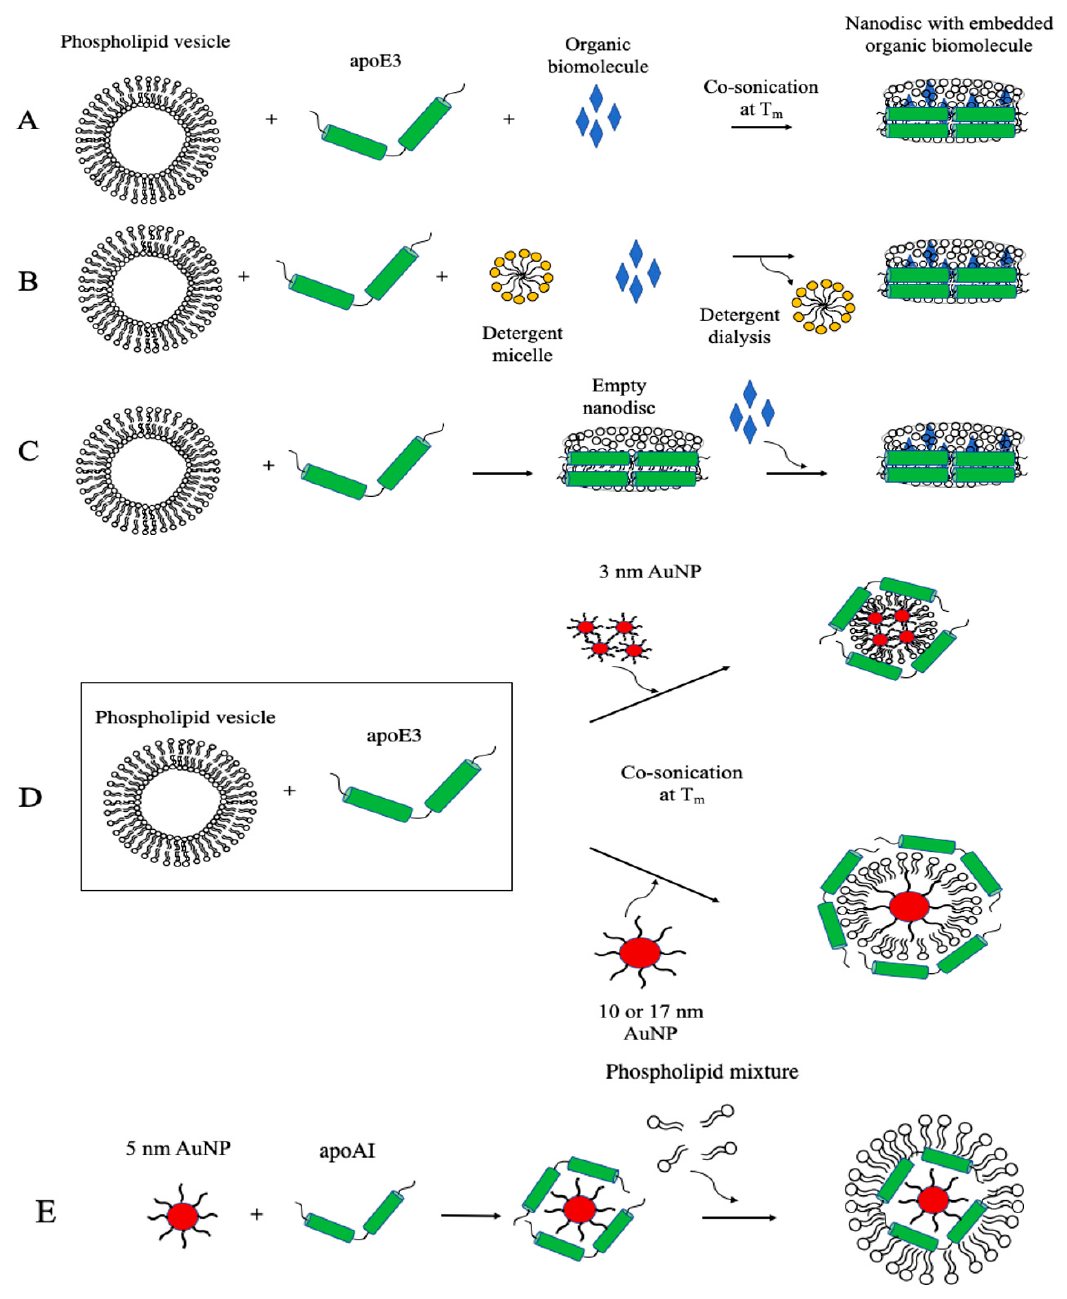
Figure 4. Incorporation of nonpolar molecules into apolipoprotein-based nanostructures. Nonpolar molecules’ incorporation into apolipoprotein-based nanostructures can be achieved by di ff erent approaches. ( A ) Co-sonication method; ( B ) detergent dialysis method; ( C ) incorporate hydrophobic molecules into pre-formed empty nanodiscs; ( D ) co-sonicate 3, 10 or 17 nm gold nanoparticles (AuNP) with phospholipid vesicles and apoE3; ( E ) build HDL-like lipoproteins around AuNP as a core template with apoAI and phospholipids.